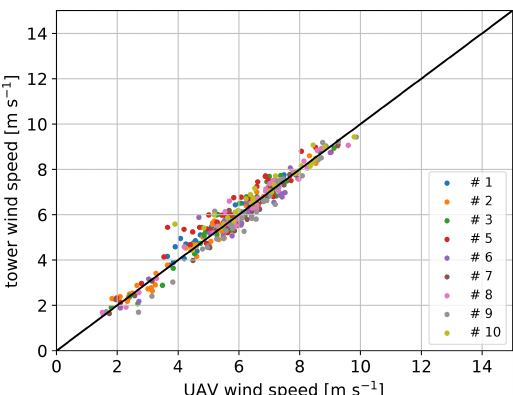
Figure C2. Two-minute averaged wind speed for n = 12 flights from the second week drone vs. tower using the universal parameter – only individual pitch offset is calibrated from flight number 31 and 56 (scenario